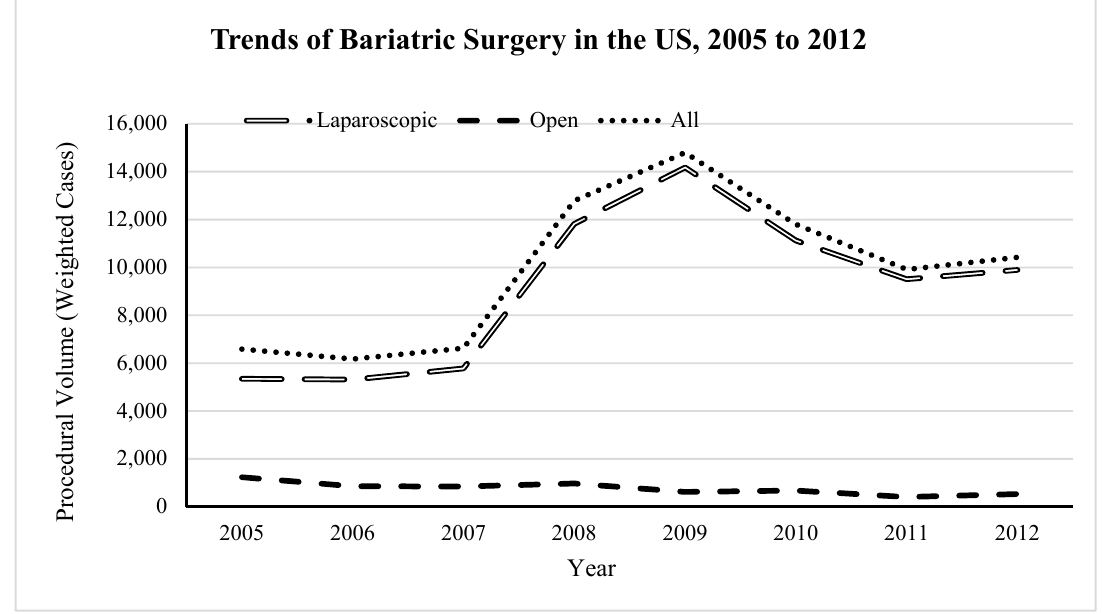
Figure 1. Temporal trends of bariatric procedures in the United States in older adults, 2005–2012. Table 1. Comparison of clinical characteristics between patients undergoing open versus closed bariatric procedures. LOS: Length of